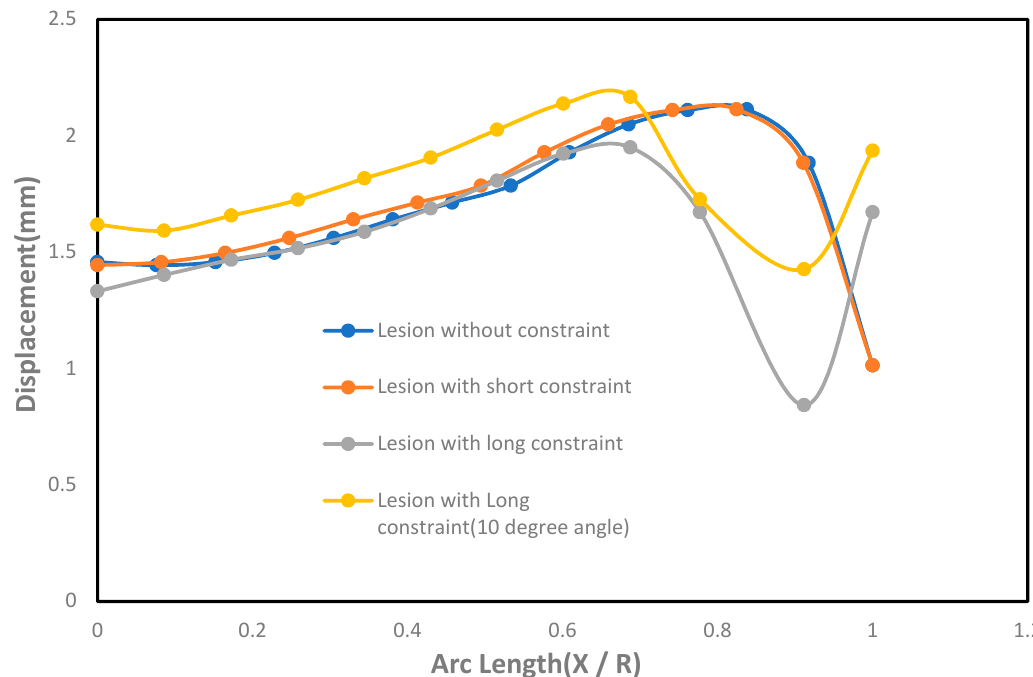
Figure 6. E ff ect of displacement (mm) with the undeformed arc length (X / R) on the axisymmetric intracranial saccular aneurysm for the cases where lesions without constraints, lesions with short constraints, lesions with long constraints, and lesions with long constraints at an angle of 10 degrees from the horizontal axis. Associated results were shown in both meridional and circumferential directions as a function of nondimensional undeformed arc length (X / R), where X = 0 corresponds to the fundus and X = R corresponds to the neck.